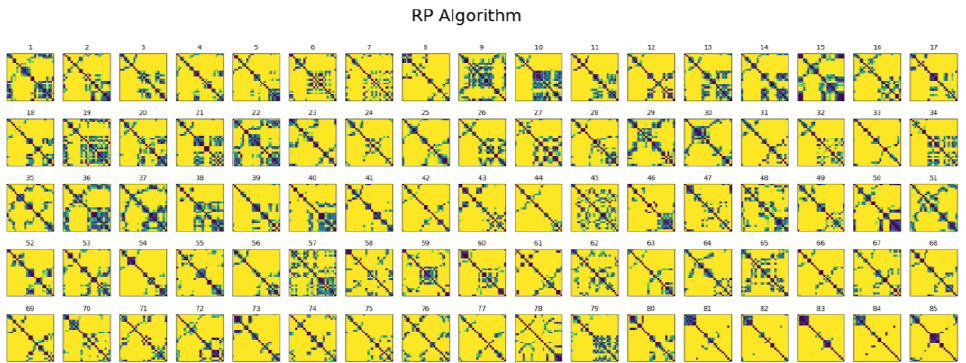
Figure 10. Time series image datasets recorded for 85 days (RP).